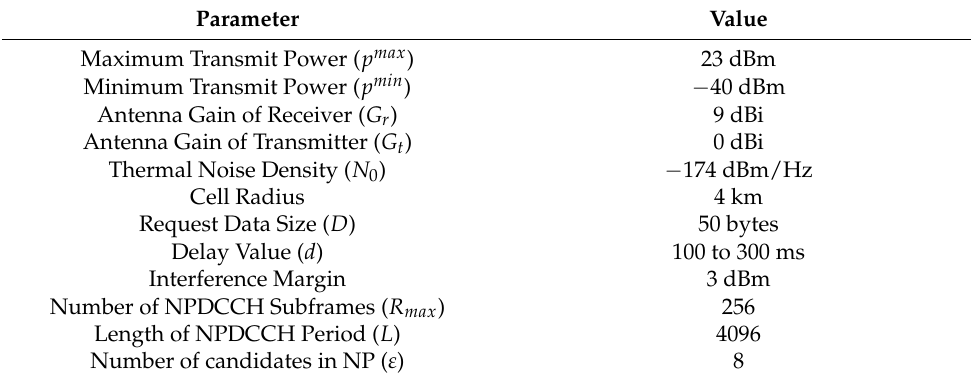
Table 12. The Simulation Parameters